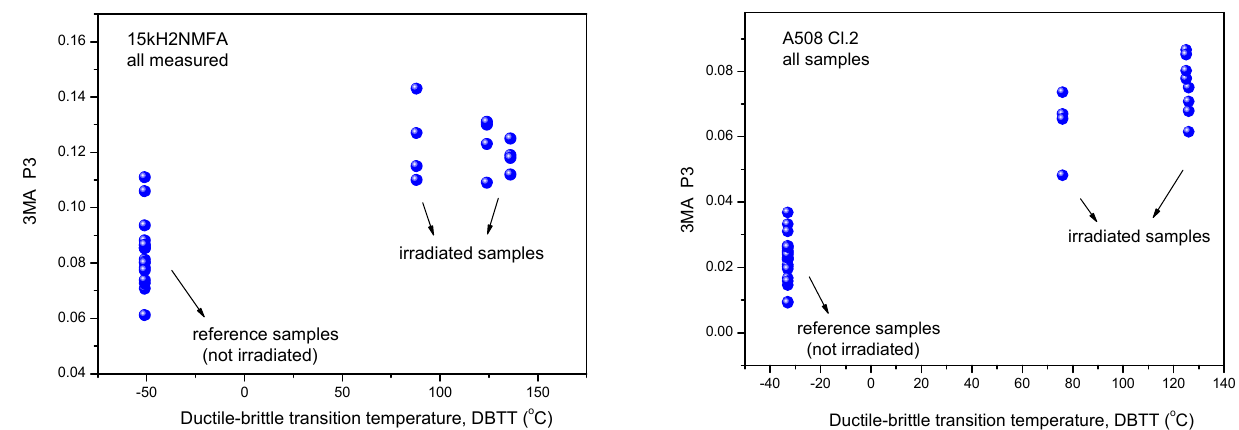
Figure 3. Optimally chosen MAT descriptor vs. transition temperature for all measured 15kH2NMFA and A508 Cl.2 samples.